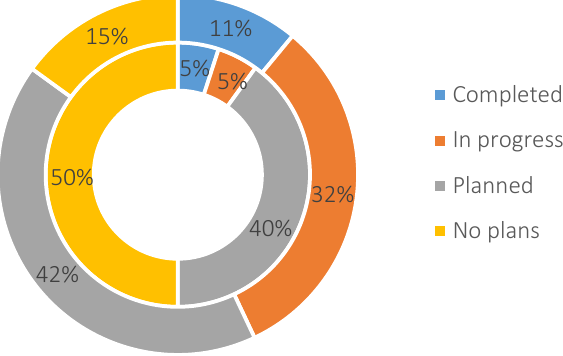
Figure 6. The activity of banks related to the establishment of sustainable credit risk plans at the end of